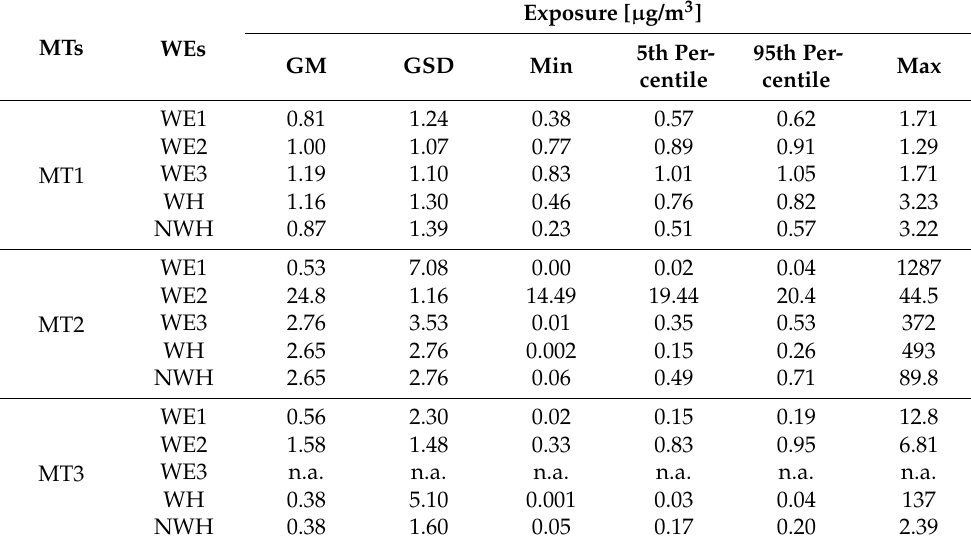
Table 3. Descriptive statistics for results of the 10,000 Monte Carlo simulations used to estimate the distribution of exposure values for the considered work events (WEs), characterized by means of different measurement techniques (MTs). Exposure to CNTs was expressed as mass concentrations [ µ g/m 3 ]. The data are presented as geometric mean (GM), geometric standard deviation (GSD), minimum and maximum values (min, max) and 5th and 95th percentiles. Note: n.a. = not available. Exposure [ µ g/m 3 ] MTs WEs 5th Per- 95th Per- GM GSD Min centile centile